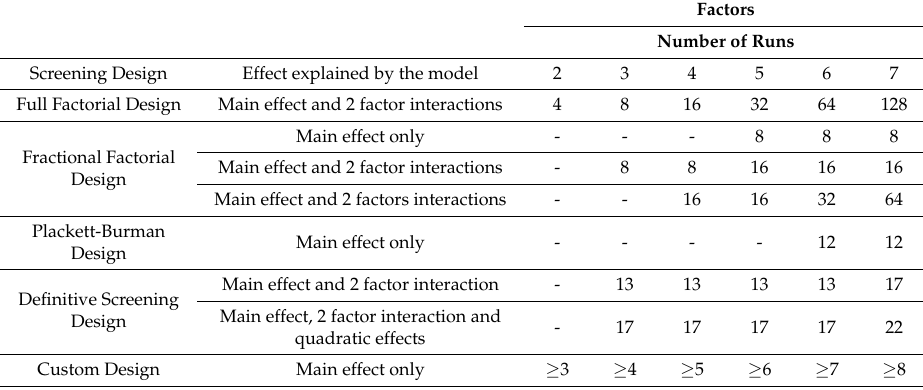
Table 3. A comparison of DoE screening designs commonly used in optimizing recombinant protein production. The table lists the types of screening designs; the effect explained by the model along with number of factors and associated number of runs (a rune refers to an experiment). It should be noted that extra runs (such as those related to central points) can be added when required. Custom design is more flexible and allows the designer to select the number of experimental